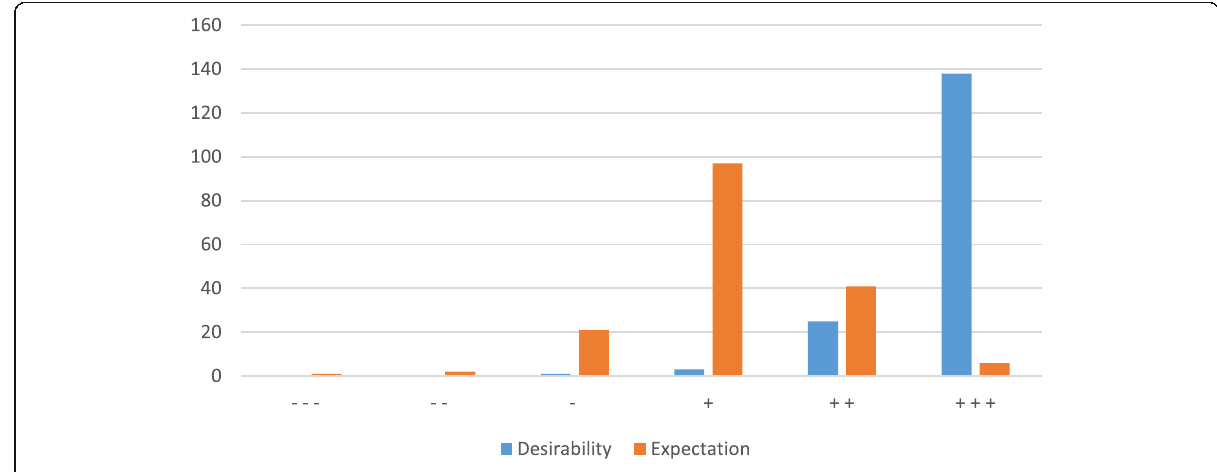
Fig. 3 Desirable and likely developments for dropout rates in area-based education